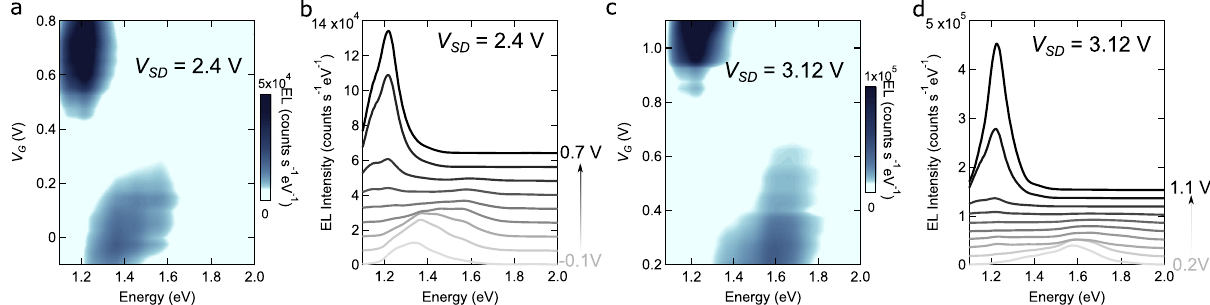
Fig. 6 Gate-tuning of the spectrum of the light emitted from a 2L-WS 2 /4L-InSe LEFET device. a Color plot of the intensity of the light emitted by a 2L- WS 2 /4L-InSe LEFET device as function of photon energy and gate voltage ( V SD is fi xed to + 2.4 V). The data show that varying V G allows the frequency of the emitted light to be tuned: for V G > 0.4 V, the spectrum is peaked at 1.25 eV, i.e., the characteristic energy of the interlayer transition between the bottom of the InSe conduction band and the top of the WS 2 valence band; for V G < 0.2 V a broader peak centered around 1.4 eV and shifting with varying V V – 0.1 to + 0.7 V in 0.1 V steps. c and d Same measurements as in G is observed. b Individual horizontal cuts of the color plot shown in a , for G varying from a and b with V SD fi xed at + 3.12 V. The individual spectral cuts range from V G = + 0.2 V to + 1.1 V in 0.1 V